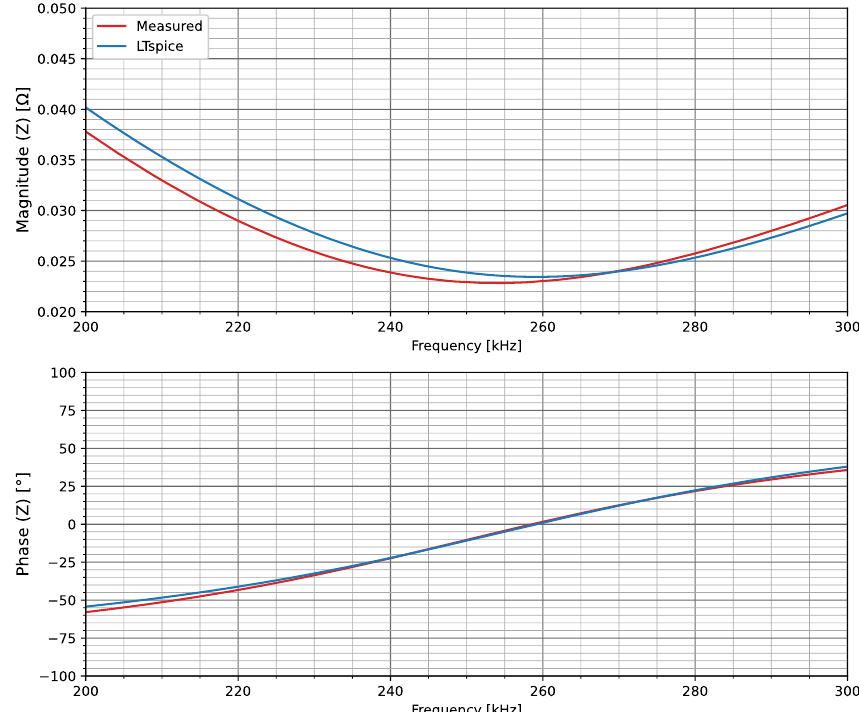
Figure 26. Large PV module measured (shunt-thru) and simulated per-cell impedance curves (frequency range 200kHz to